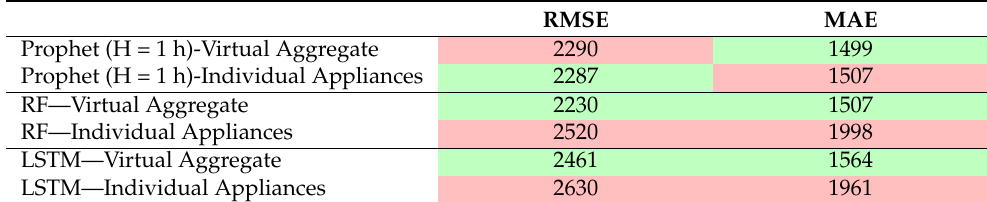
Table 4. Performance metrics of different algorithms’ comparison for the normalized virtual